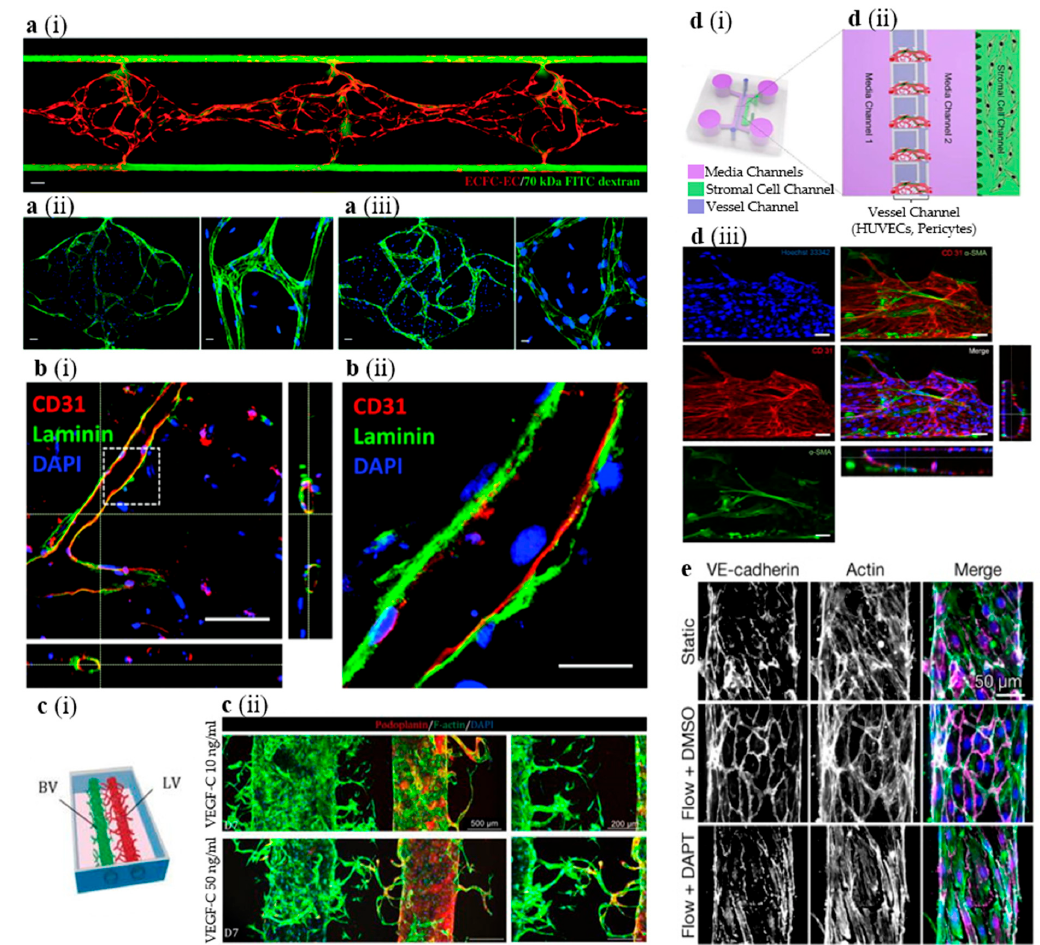
Figure 2. A collection of blood vasculature on-chip in vitro models that recreate different aspects of blood vessel anatomy and physiology. ( a ) The multiwell tissue flow chambers of Hughes lab’s on-chip model illustrate (i) the EC (mCherry) vascular networks formed after 7 days and the flow of 70 kDa FITC-dextran 30 min after perfusion, (ii) the distribution of Claudin-5 (Alexa Flour 488) and nuclei (4× and 20× magnification), and (iii) the expression of VE-cadherin junctions (Alexa Flour 488) and nuclei (DAPI) (4× and 20× magnification). Scale bar = 50 µm [17]. ( b ) The iPSC-EC microvessels display complete lumens with laminin deposition in the basement membrane, Scale bar = 100 µm, in (i) and 25 µm in (ii) [18]. ( c ) A double vessel chip (i) with separate channels for blood vessel (BV) and lymphatic vessel (LV) shows the effect of different VEGF-C concentrations on angiogenesis and lymphangiogenesis [19]. ( d ) A multichannel chip (i) overview schematic and (ii) cross-sectional schematic illustrating the layering of the pericytes (stromal cells) with the endothelial cells and fluid media channels. (iii) Immunostaining with confocal microscopy reveals the architecture of the microvessel including complete lumen formation and pericyte incorporation through Hoechst 33,342 staining of the nuclei (blue), CD31 as an EC marker to illustrate angiogenesis (red), and α -SMA (smooth muscle actin alpha) as a marker of pericytes (green) following fixation 8 days after seeding. Scale bars = 40 µm [20]. ( e ) Immunostaining for VE-cadherin (magenta), labelled with DAPI (blue), and the actin stain phalloidin (green) as compared with the structure of human engineering microvessels (hEMVs) in static conditions and exposed to flow containing either dimethyl sulfoxide (DMSO) or DAPT (a Notch signaling inhibitor). Scale bar = 50 µm [21]. Figure republished with permission from each indicated reference as follows: [17] for part (a), [18] for part (b), [19] for part (c), [20] for part (d), and [21] for part (e). A promising in vitro model technique that incorporates physiological flow while allowing